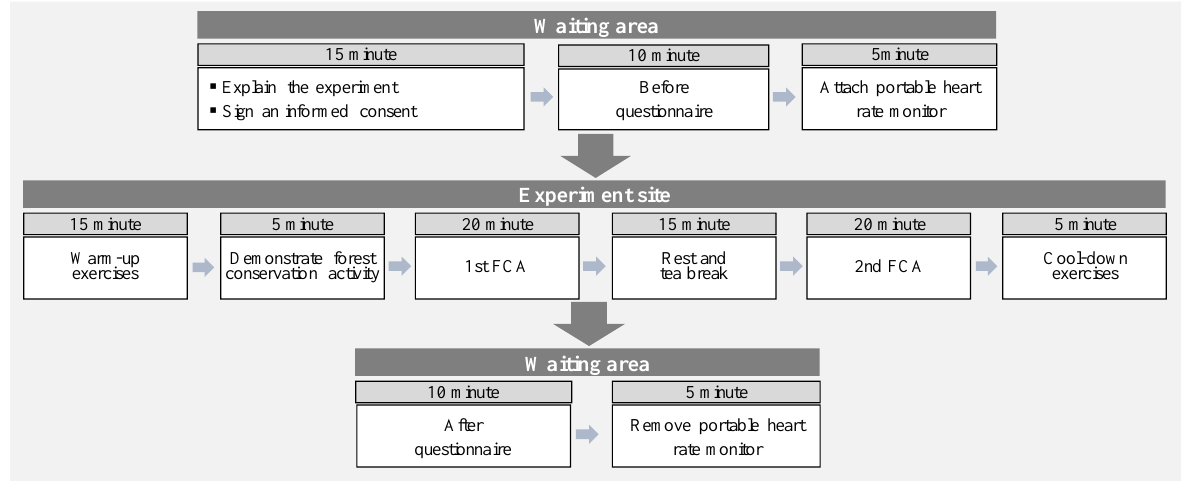
Figure 2. FCA program.